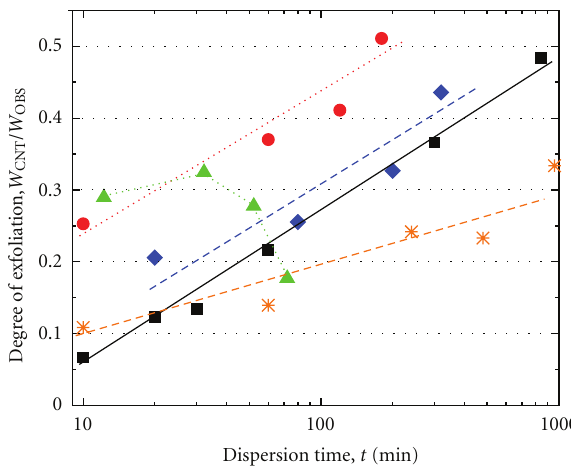
Figure 9: Thermogravimetric analysis of two suspensions and ref- erence samples. The curves have been shifted on the Y -axis for bet- ter clarity. The reference samples were measured as received. The polymer stabilizer (D2150) was dissolved in a solvent by the sup- plier, and the large mass loss at 70 ◦ C is due to evaporation of this